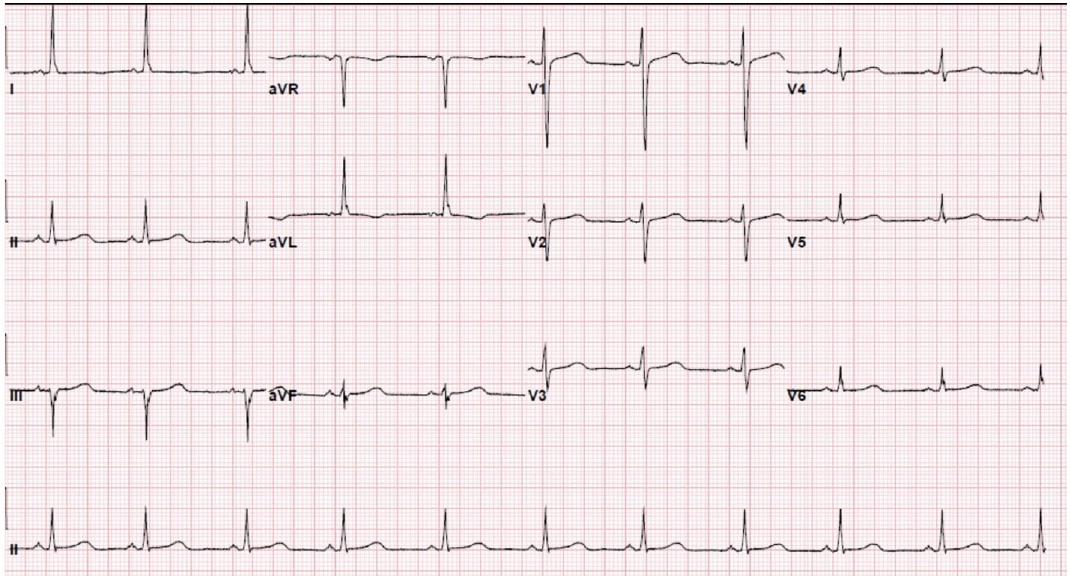
Figure 4: Electrocardiogram showing normal sinus rhythm with no ST-T wave